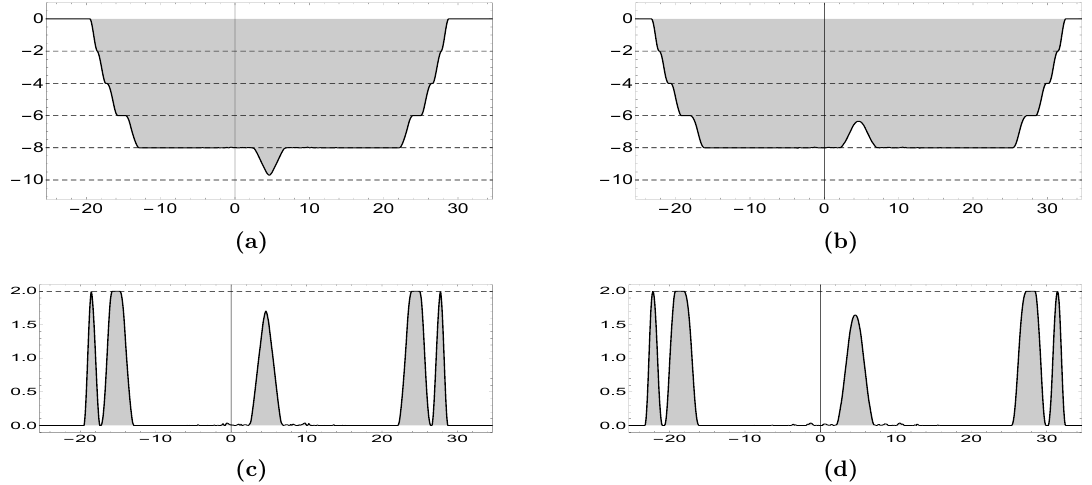
Figure 24. Four pairs of kink-antikink states and the oscillon in the centre for l = 9 : 2346 at (a,c) t = 23 : 879, (b,d) t = 27 : 829. Figures (c,d) represent folded (original) (cid:12)eld (cid:22) (cid:17) ( t; x